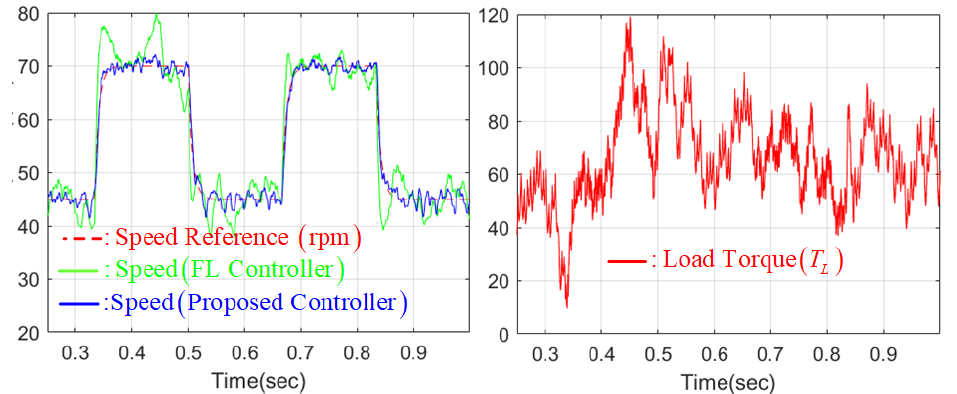
Figure 4. Speed tracking performance comparison result with load torque behavior at cut-off frequency of f sc = 20